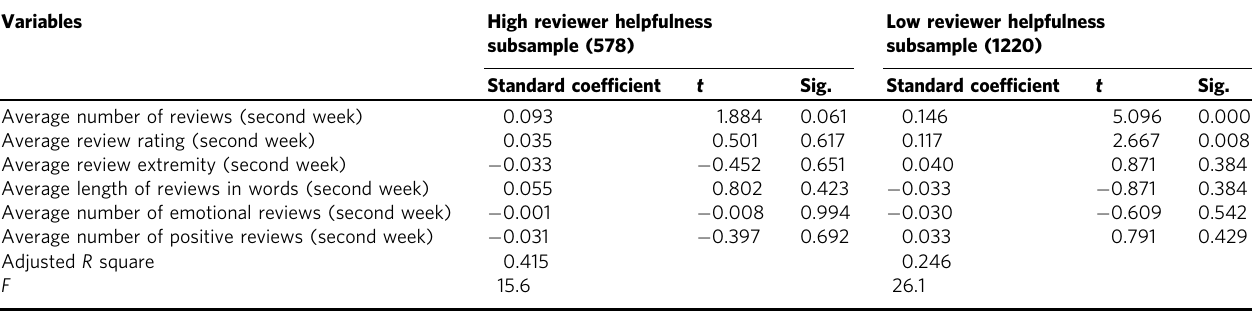
Table 8 Regression analysis for box of fi ce revenue for the third week after release using reviewer helpfulness subsample.